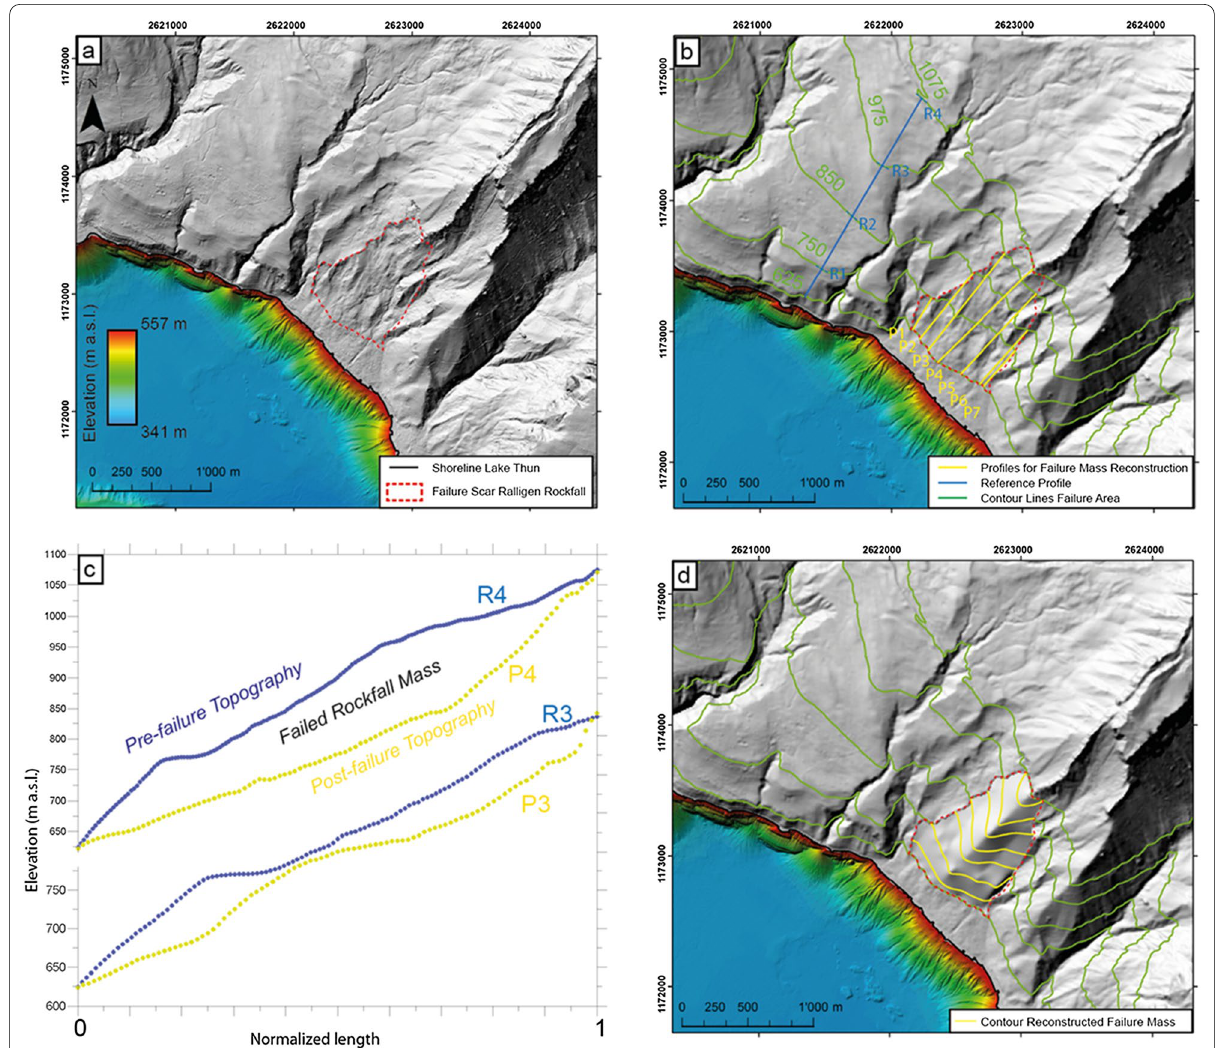
Fig. 2 Pre-failure topography reconstruction on-shore. a Digital elevation model (SwissAlti3D Swisstopo, Swiss Federal Office of Topography, 315/45 illuminated) with bathymetric map superimposed. Failure scar of the Ralligen Rockfall is illustrated. b Choosing an intact reference profile (blue) nearby the failed area and projecting it on to the failure zone along profiles P1-P7. c Comparison between post-failure and pre-failure topography for two selected profiles at P3 and P4. d Reconstructed topography with contour lines based on 7 projected